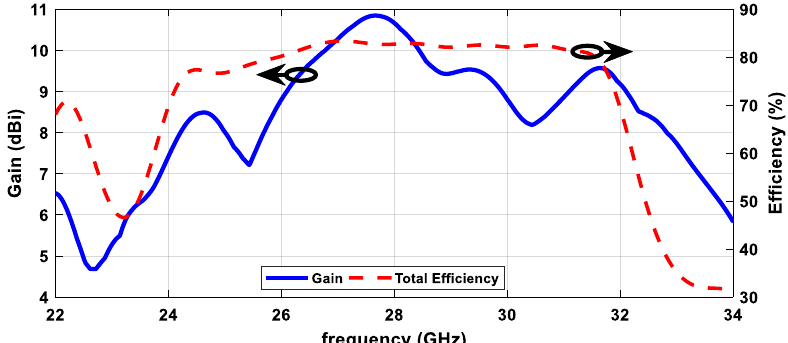
Figure 10. Variation of the Gain and Efficiency of the 7-element array over the frequency.